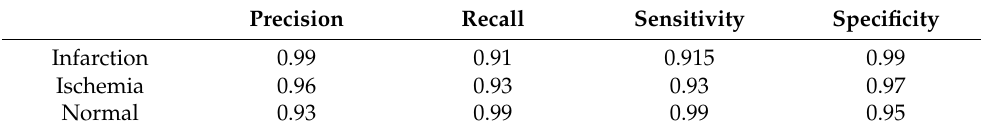
Table 10. Presentation of metrics of VGG-16 for each class, after a 10-fold procedure. Precision Recall Sensitivity Specificity Infarction